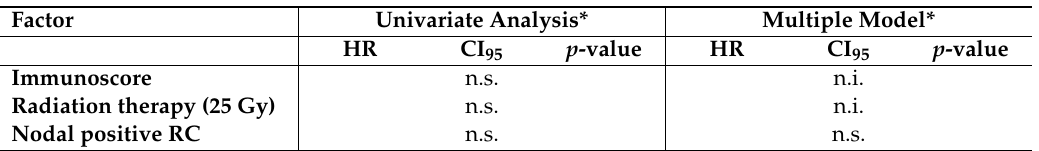
Table 8. Univariate and multiple Cox Regression analysis for overall survival of rectal cancer patients using the Immunoscore (2 cores per tumor area, virtual TMA).